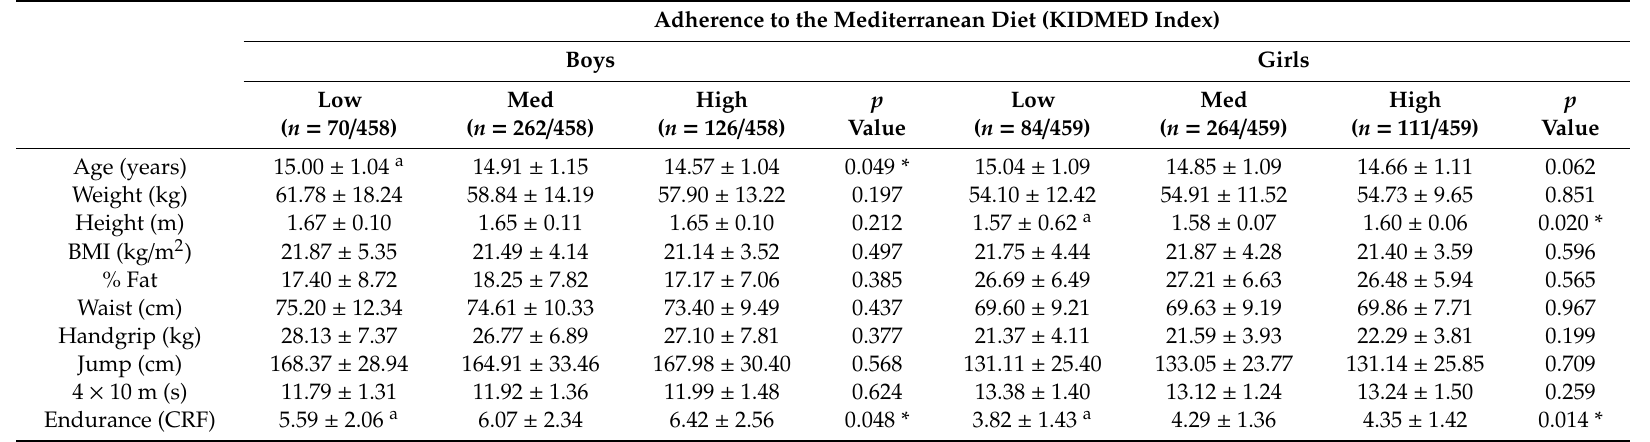
Table 3. Anthropometric characteristics and physical fitness variables of stratified according to adherence to the MD in both genders. Adherence to the Mediterranean Diet (KIDMED Index) Boys